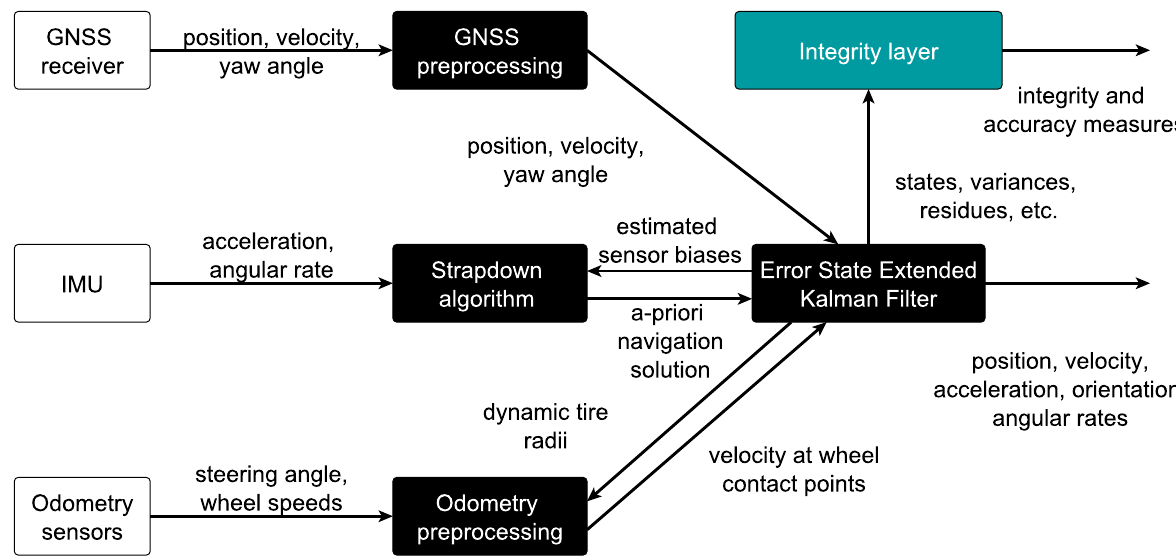
Figure 3. Block diagram of Global Navigation Satellite System (GNSS)/Inertial Measurement Unit (IMU)/odometry fusion filter used for comparison of implemented integrity algorithms (Figure based on